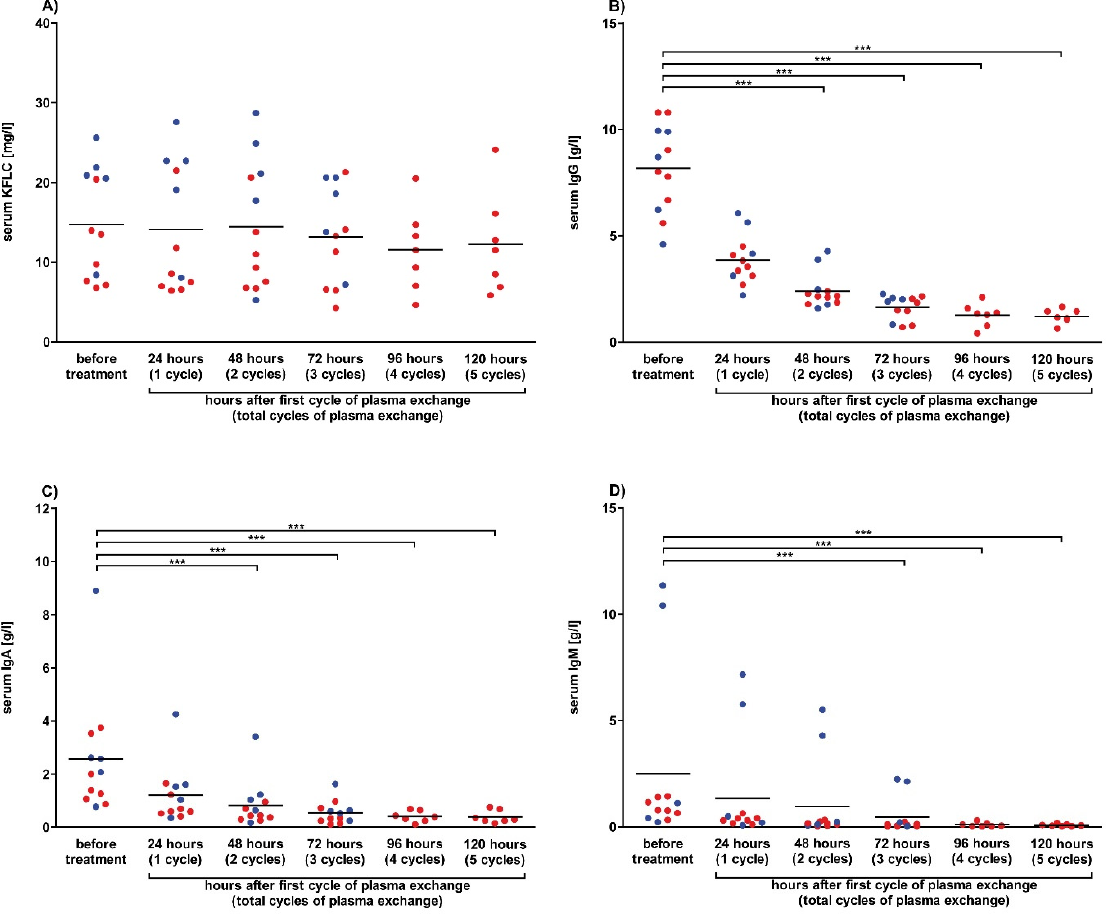
Figure 4. Serum concentrations after plasma exchange in prospective patients. Serum concentrations of patients whose data and samples were collected in 2018 and 2019 are shown. Depicted are serum concentrations of kappa free light chains (KFLC) ( A ), immunoglobulin type G (IgG) ( B ), IgA ( C ), and IgM ( D ). Patients treated with 3 cycles of plasma exchange therapy are depicted as blue dots (n = 5), while patients with 5 cycles of treatment are depicted as red dots (n = 7). Blood samples were taken before and after 24, 48, 72, 96, and 120 h of treatment with one cycle of plasma exchange per day. p -values of significant di ff erences are illustrated as